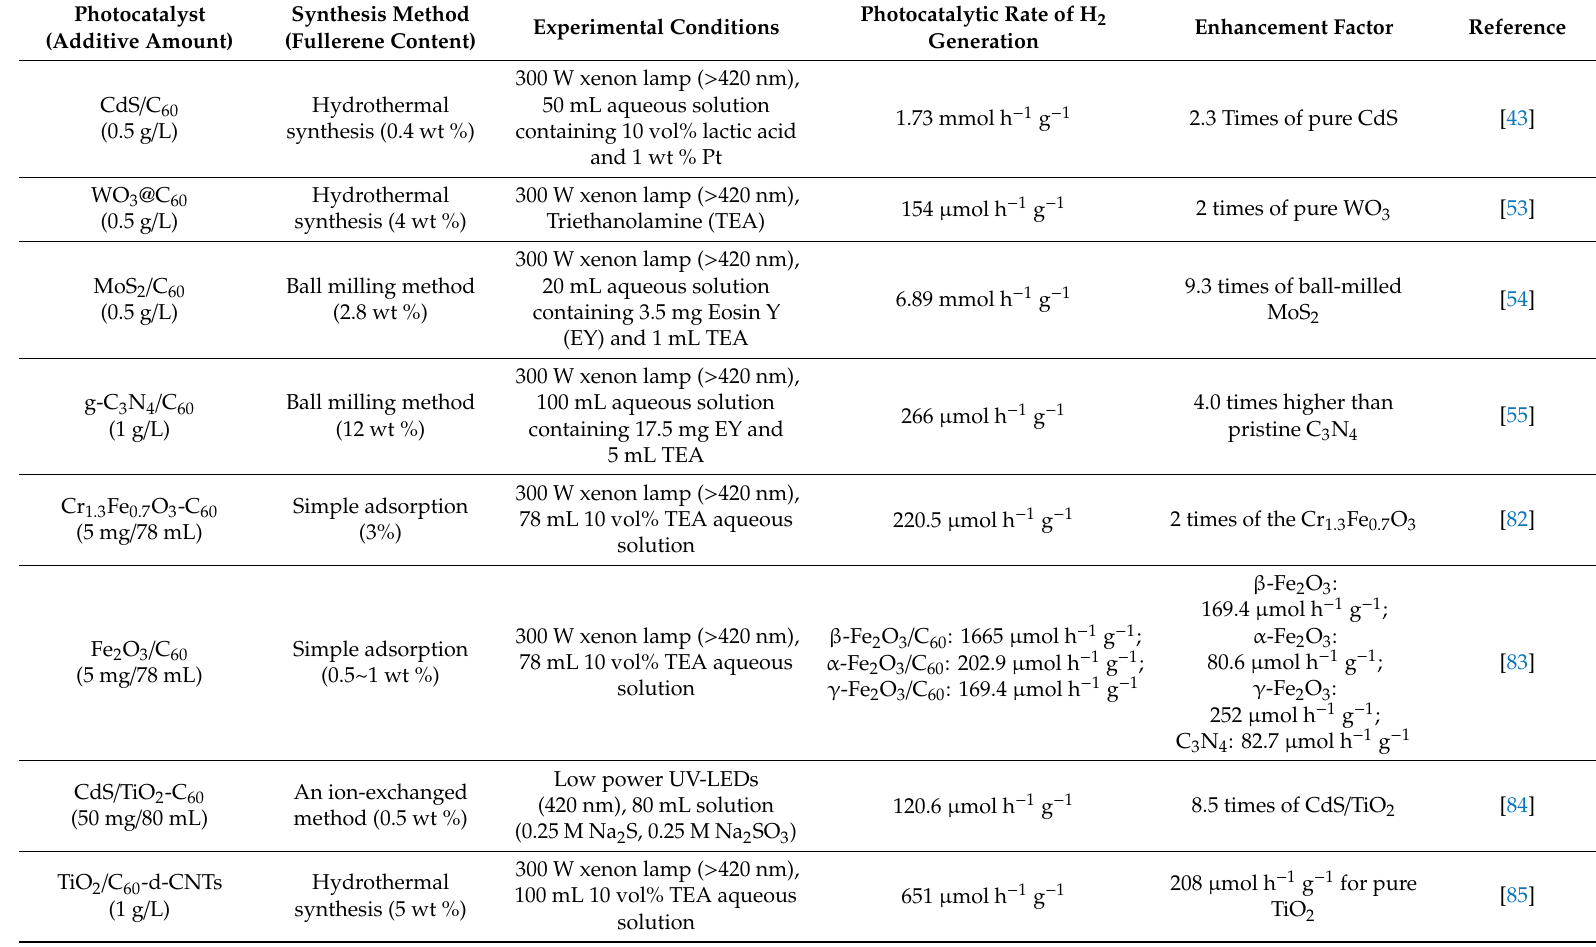
Table 2. Summary of fullerene based photocatalysts for photocatalytic H 2